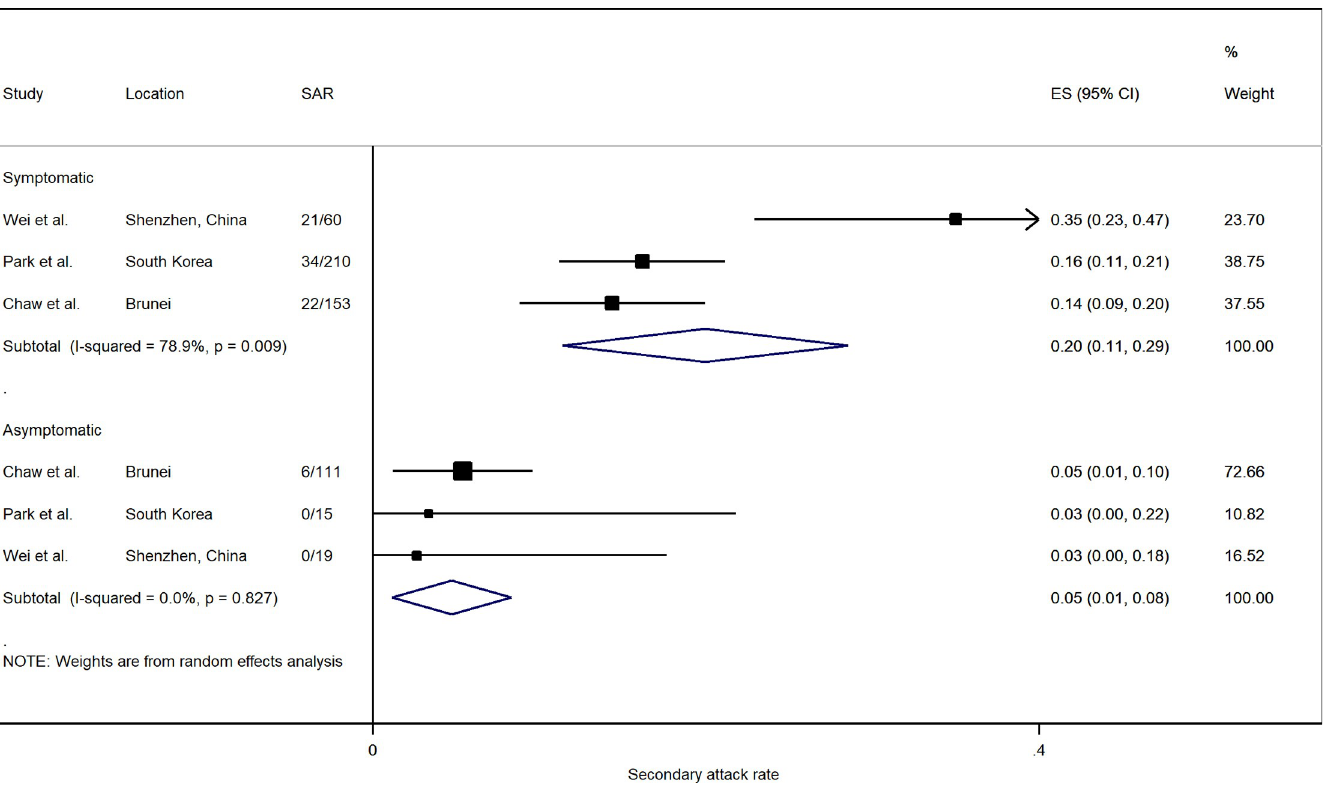
Fig 4. Forest plot of household secondary attack rates (SAR) by symptom status of index case. ES is the estimated SAR, with 95% confidence intervals (CI). I-squared is the percentage of between-study heterogeneity that is attributable to variability in the true effect, rather than sampling variation.